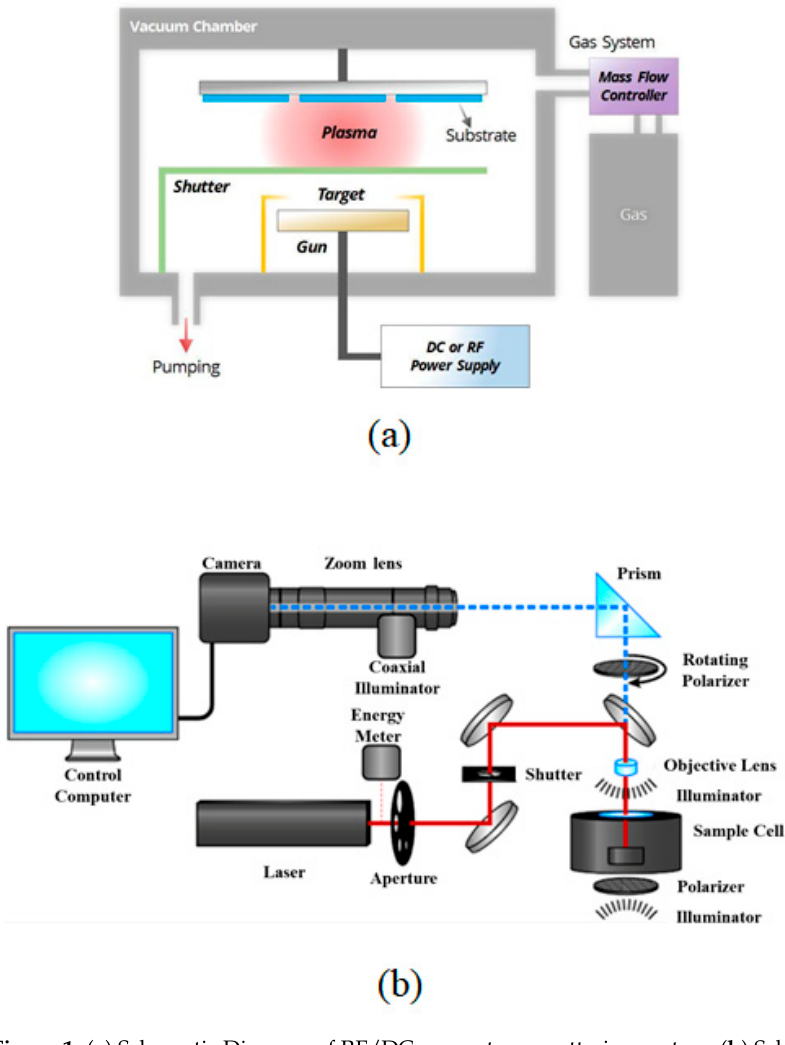
Figure 1. ( a ) Schematic Diagram of RF/DC magnetron sputtering system, ( b ) Schematic Diagram of the LSX-213 Laser Ablation System.